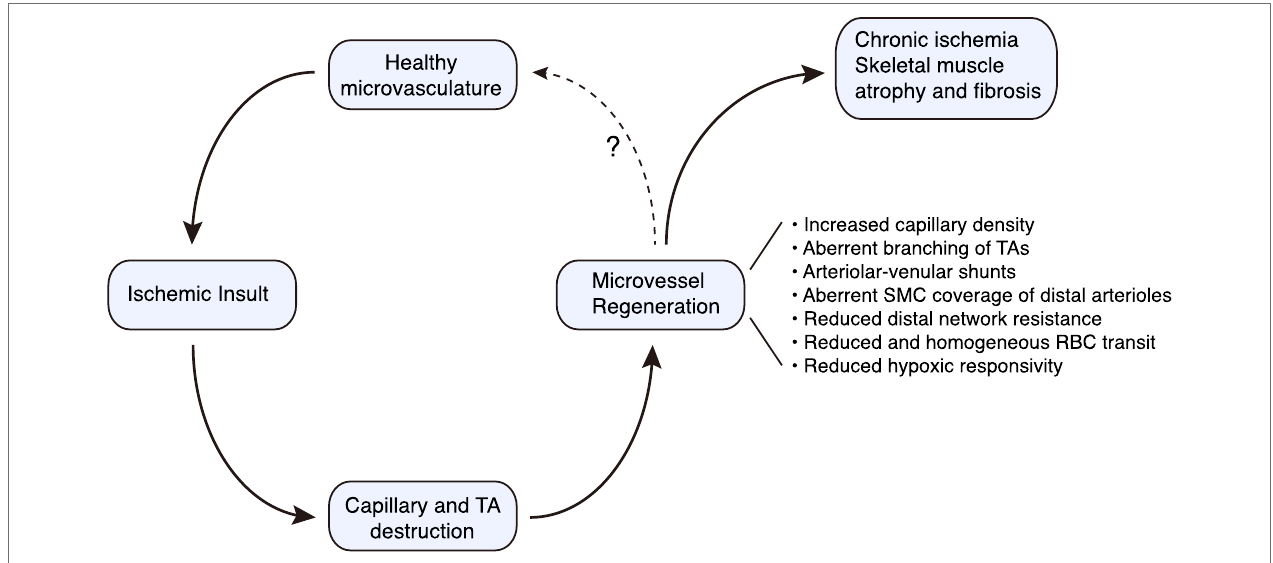
FIGURE 2 | Conceptual paradigm for regenerative angiogenesis in the mouse hindlimb subjected to ischemic injury. Microvascular regeneration proceeds robustly following severe ischemic injury to skeletal muscle. However, there are structural and functional deficiencies that must be overcome if optimal tissue perfusion is to be restored. TA, terminal